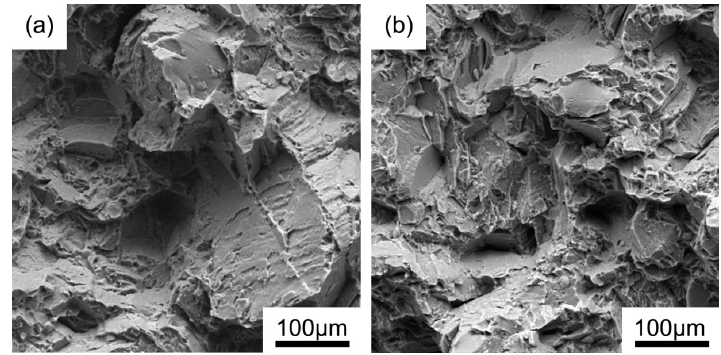
Figure 8. SEM images showing typical fracture surfaces of specimens with ( a ) 0% and ( b ) 8%, respectively, after tensile test at RT.